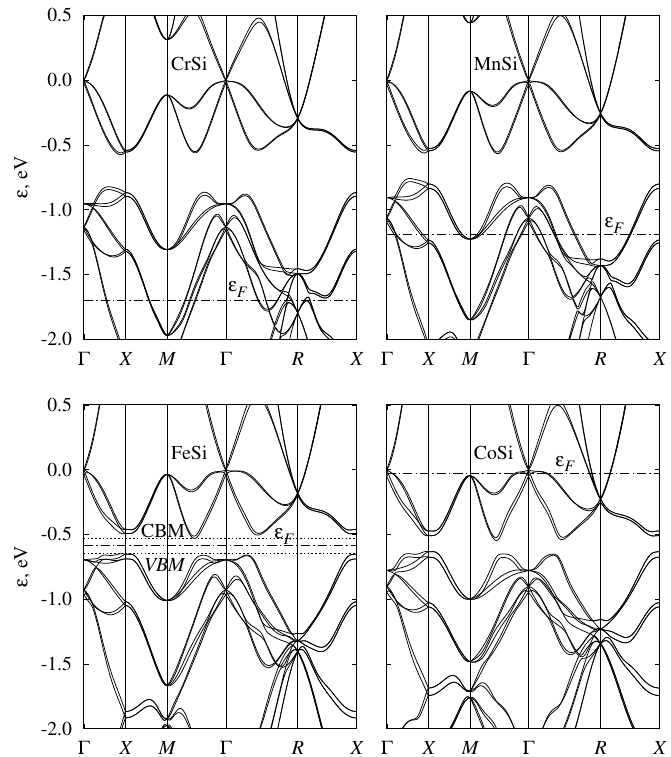
Figure 2. Band structure of CrSi, MnSi, FeSi, and CoSi with B20 (P2 1 3, #198) crystal structure. Energy is measured relative to fourfold band crossing at Γ point. Dash-dotted line shows Fermi level position. Dotted lines on FeSi panel indicate the valence band maximum (VBM) and conduction band minimum (CBM) energies along high-symmetry